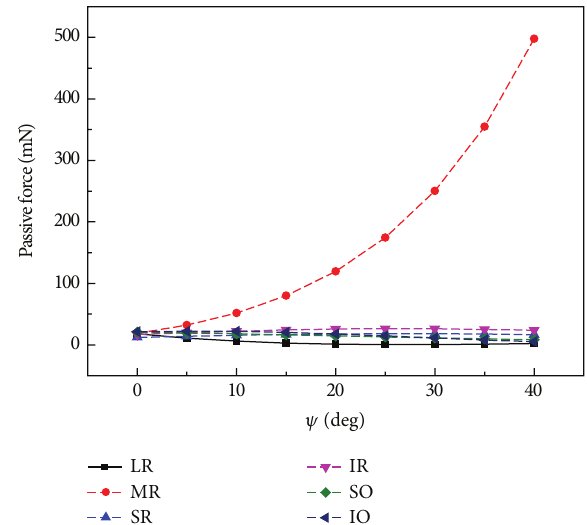
Figure 5: Passive forces of EOMs with eye passively rotated temporalward in the primary innervations.